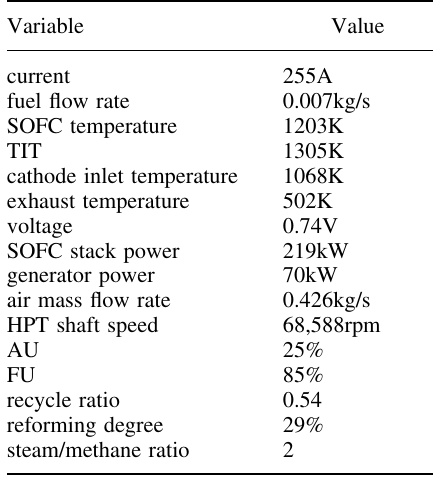
Table 2. Nominal states of the hybrid system